Question: What visual encoding does this figure use to show its data?
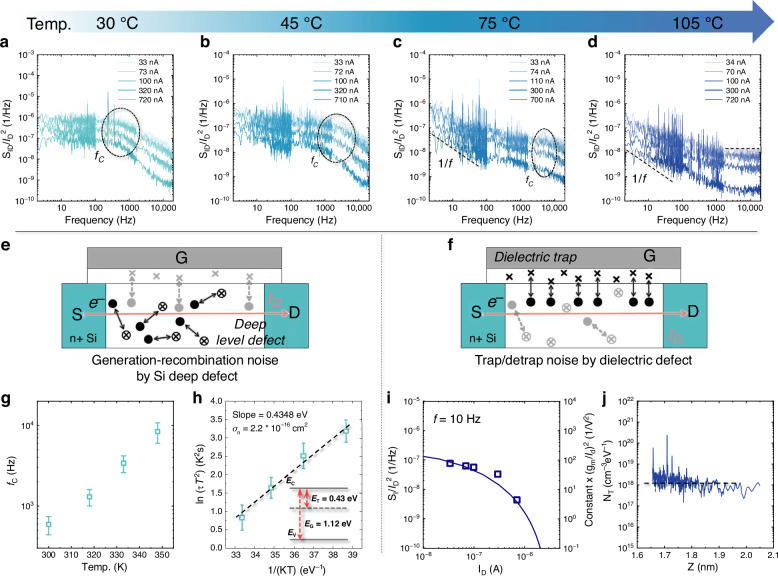
Answer: line